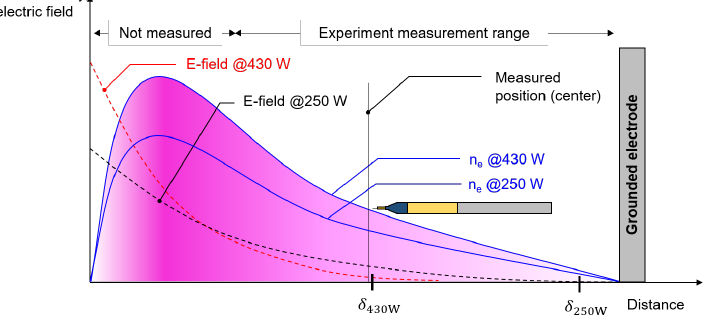
Figure 4. Schematic diagram of electron density and electric field profiles at different discharge powers.